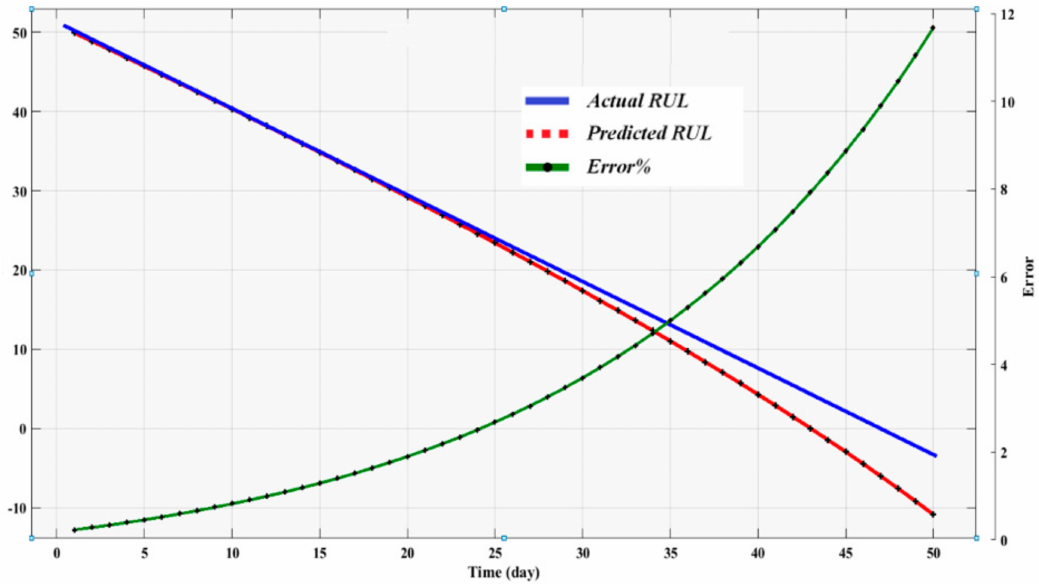
Figure 11. Artificial neural network RUL results.